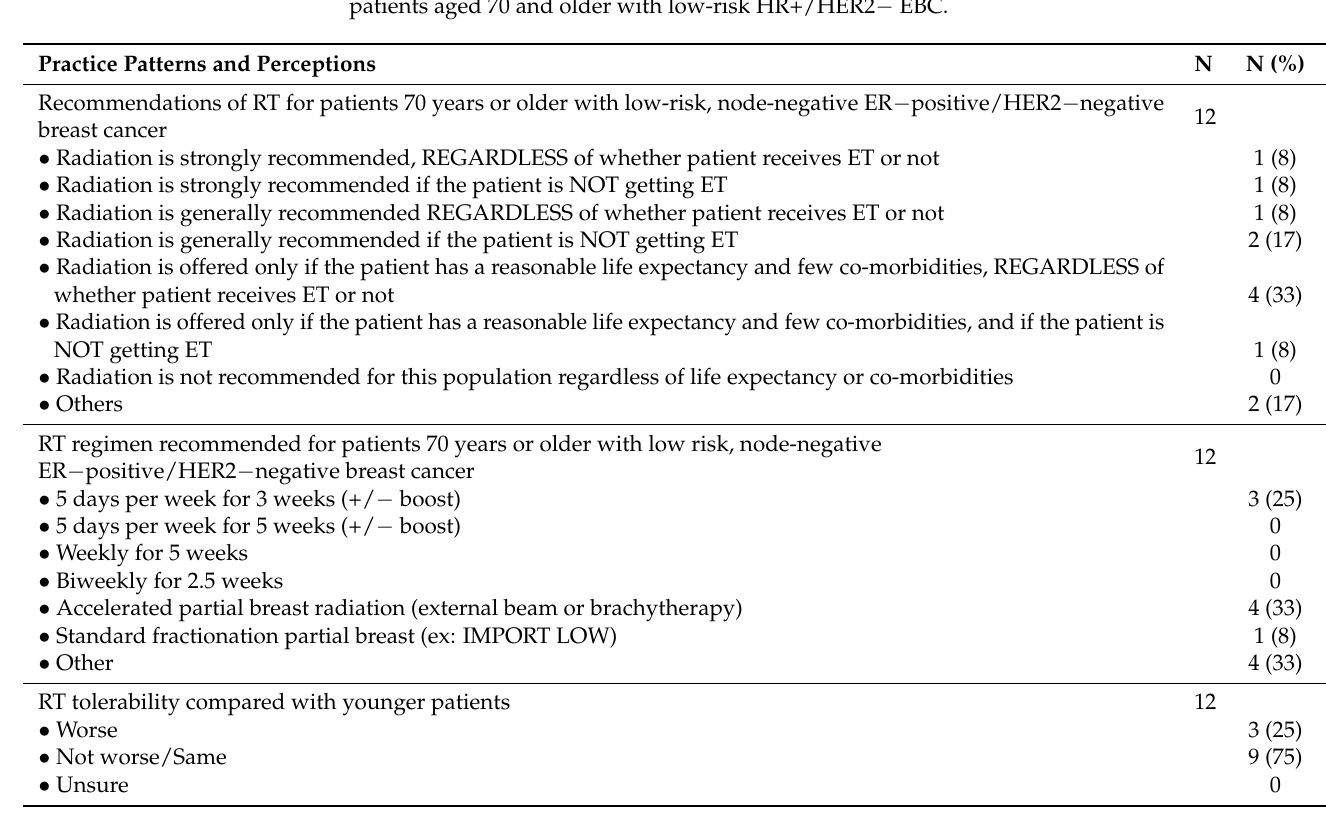
Table 3. Physician personal practice and perception with respect to adjuvant RT and ET use in patients aged 70 and older with low-risk HR+/HER2 −